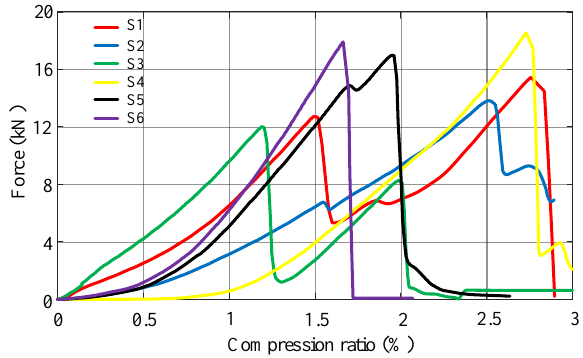
Figure 9. The figure shows the force-displacement curves for six Brazilian tests.